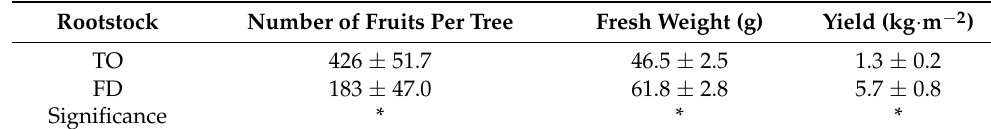
Table 2. Yield of ‘Minihyang’ mandarin grafted on trifoliate orange (TO) and Flying Dragon (FD) rootstocks at harvest.